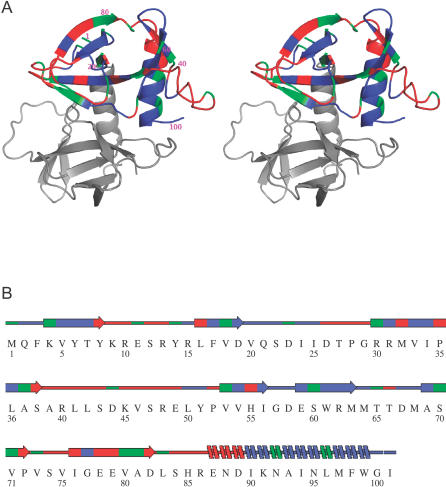
Location of Active and Inactive Pro Mutants of CcdB in the Context of the Overall 3D Structure of the Protein(A) In this stereo view, one of the protomers is shown in grey and the other in color.(B) Secondary structure representation of CcdB. Locations where Pro mutations could not be generated are shown in green, while red and blue represent locations of active and inactive mutants, respectively. Every 20th residue is labeled.